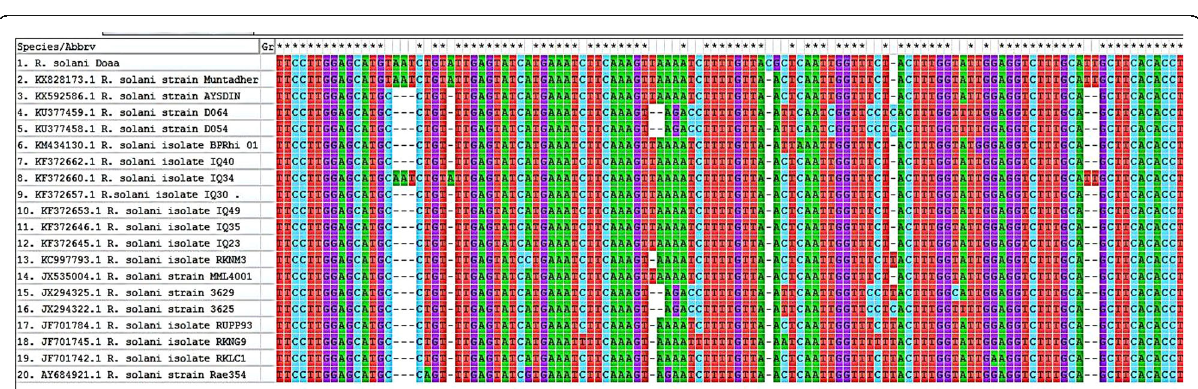
Fig. 5 Effect of the Iraqi R. solani and F. solani isolates on seed germination and seedling damping-off disease in